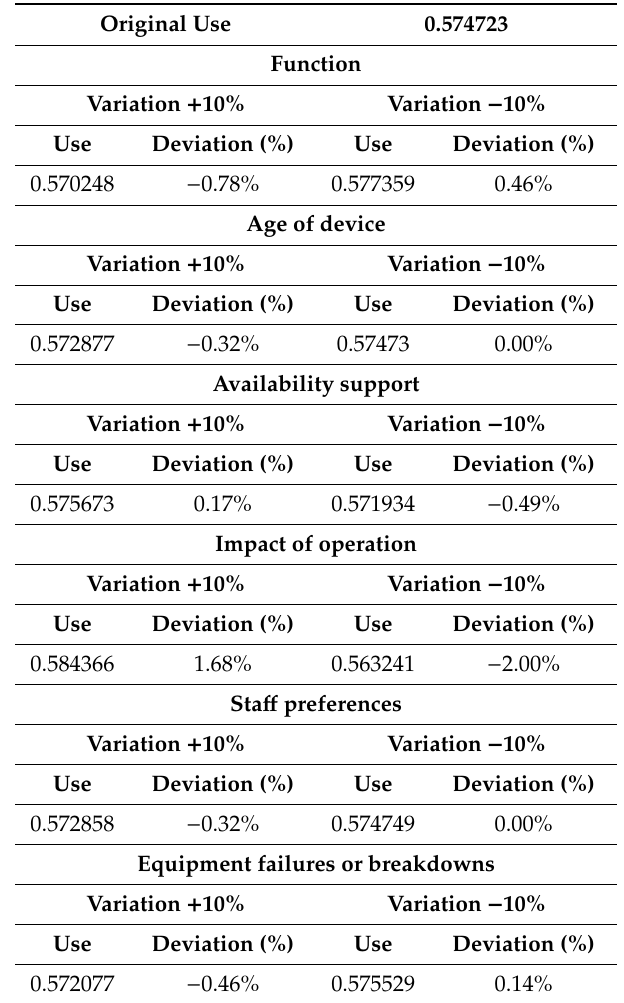
Table 31. Sensitivity analysis for X-ray surgical C-arm